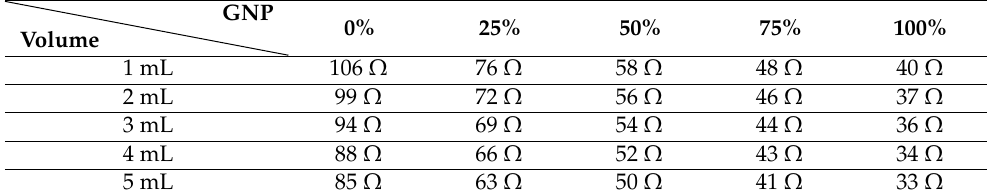
Table 2. Resistances of hybrid nanomaterial films with various spray volumes and GNP contents. Volume